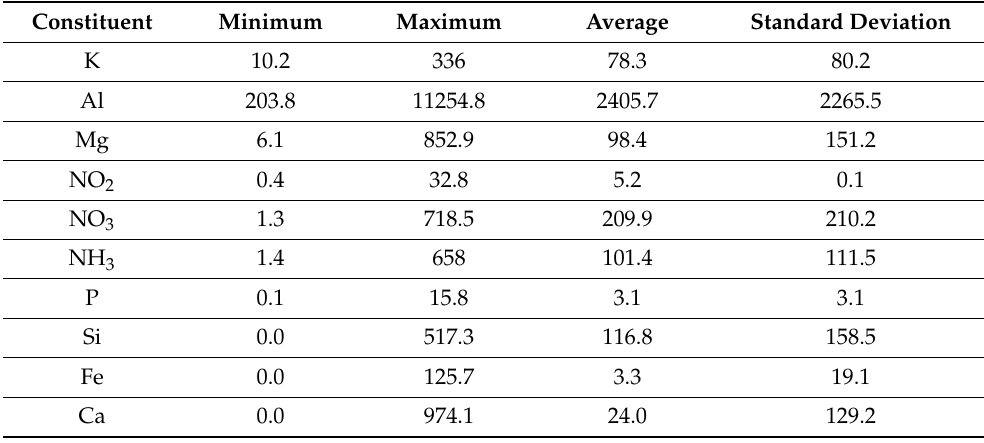
Table 3. Concentrations for digested rainfall dust using the Colorimetric Nutrient Analyzer and ICP-MS analysis methods. All values in µ